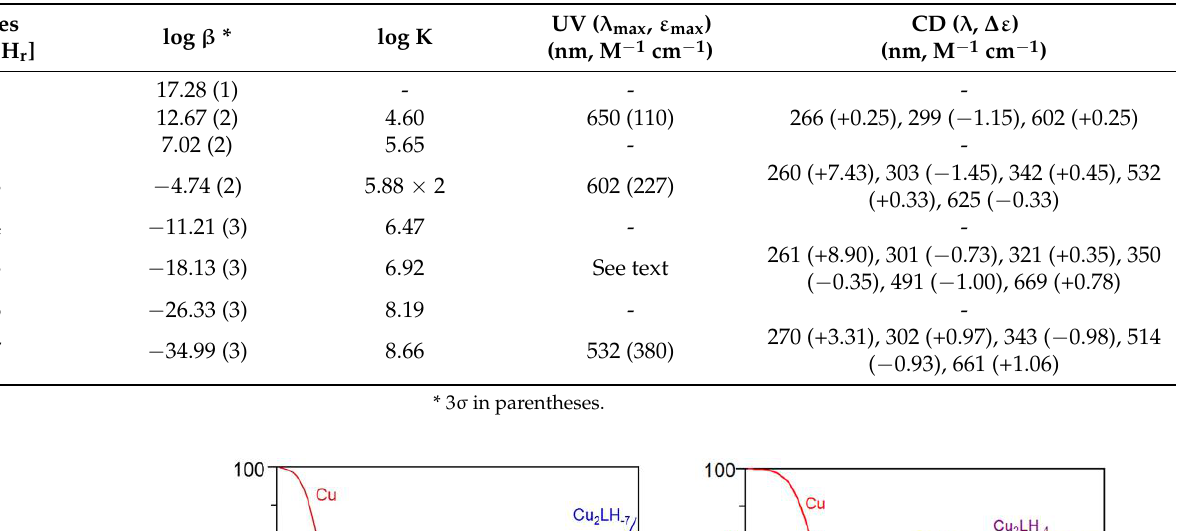
Table 1. Log β and log K values obtained from the titration of the Cu–Ang1-17 system (2:1), by varying the solution pH in the range 3–9.5.